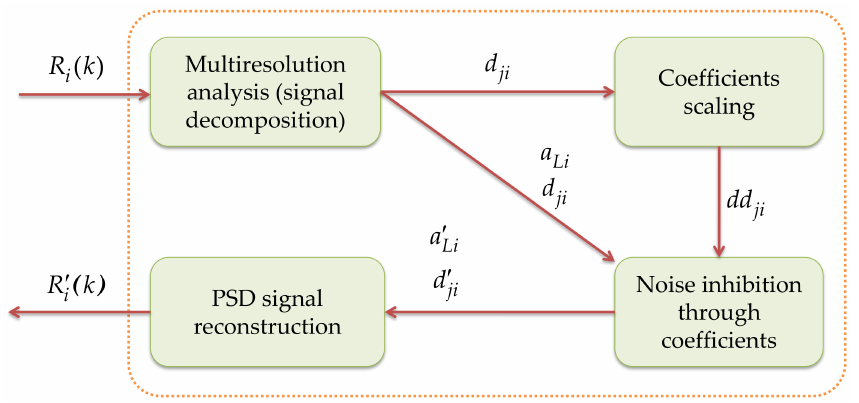
Figure 5. Operation of the impulse noise reduction